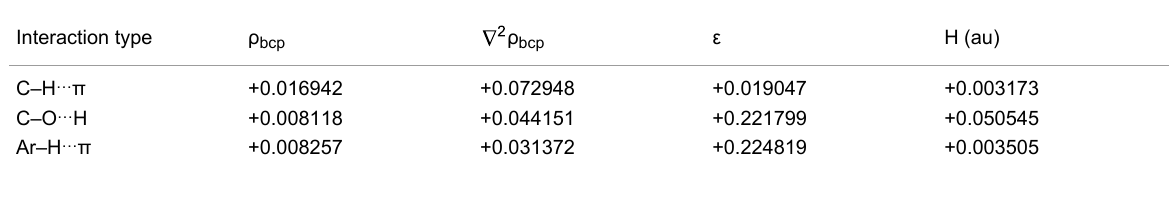
Table 1: Selected topographical features for various interactions computed at the B3LYP/6-31G** level of theory.